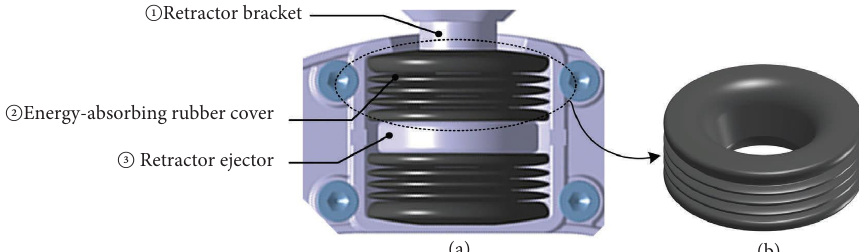
Figure 7: Damping joint structure of the new quad-bundle spacer damper: (a) damping joint component composition and (b) energy- absorbing rubber sleeve